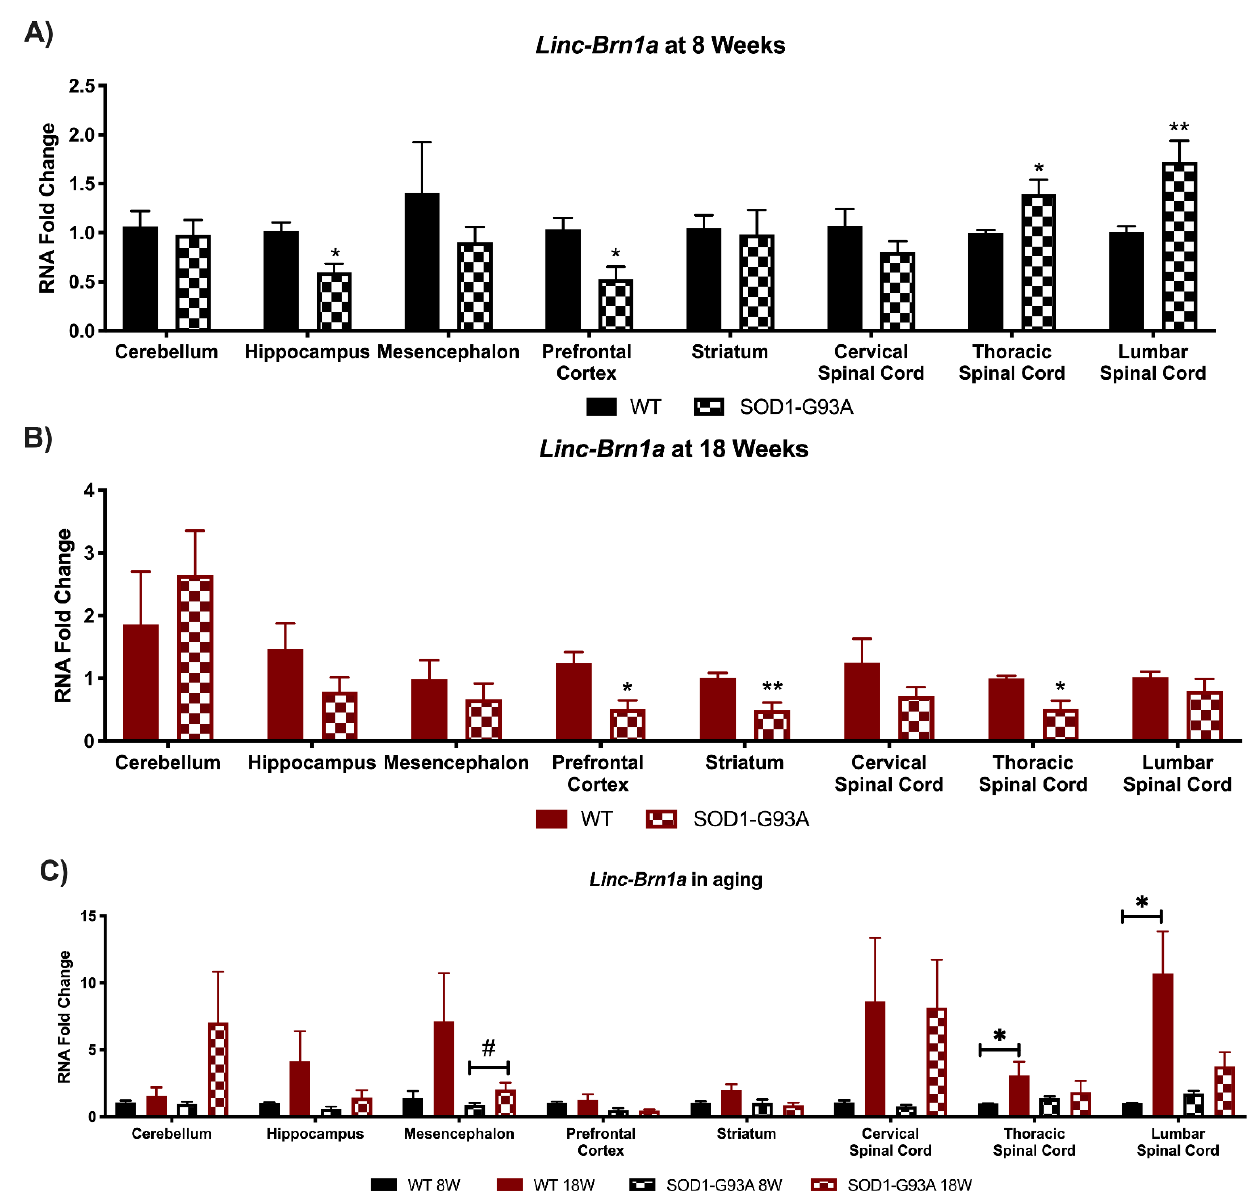
Figure 1. Global perturbations found in the expression of Linc-Brn1a in CNS areas of SOD1-G93A mice. RNAs expression levels were evaluated by Real Time-PCR in the different conditions. Data are expressed as mean ± SEM. ( A ) Linc-Brn1a expression in 8 weeks old WT ( n = 6) mice versus 8 weeks old SOD1-G93A mice ( n = 6). * p < 0.05, ** p < 0.01 vs. WT. ( B ) Linc-Brn1a expression in 18 weeks old WT ( n = 6) mice versus 18 weeks old SOD1-G93A mice ( n = 6). * p < 0.05, ** p < 0.01 vs. WT. ( C ) Linc-Brn1a expression in 8 weeks old WT mice versus 18 weeks old WT ( n = 6) and 8 weeks old SOD1-G93A mice versus 18 weeks old SOD1-G93A mice ( n = 6). * p < 0.05 vs. WT 8W, # p < 0.05 vs. SOD1-G93A 8W.